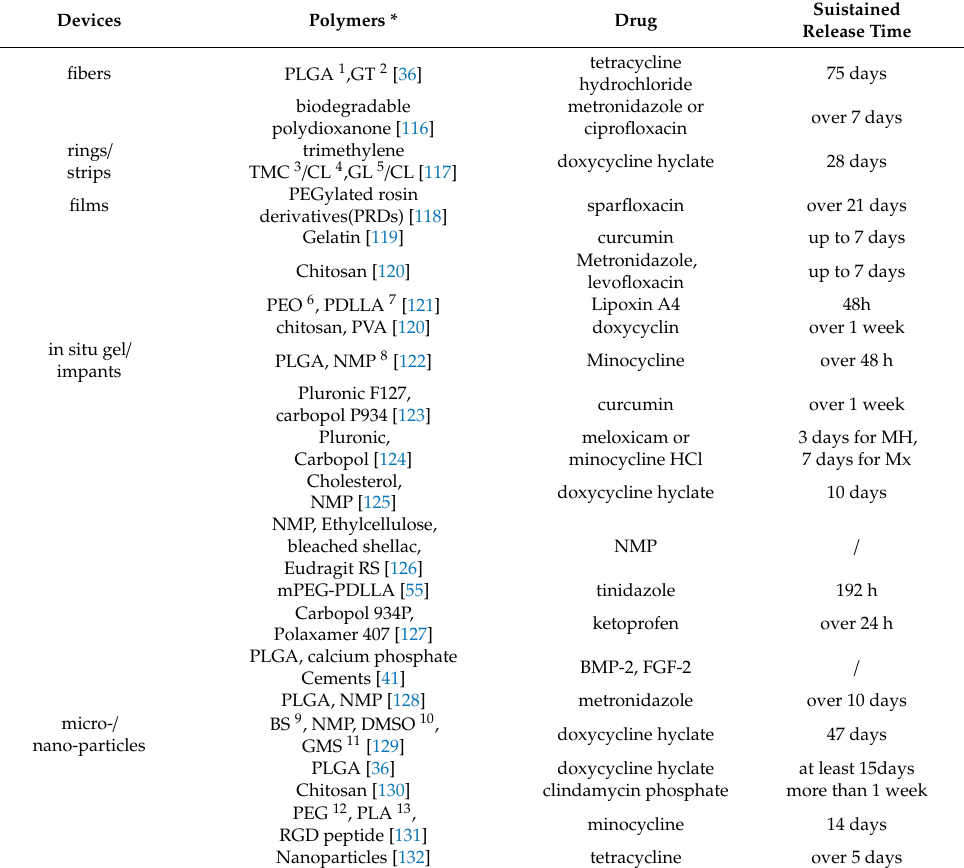
Table 2. Local DDS in